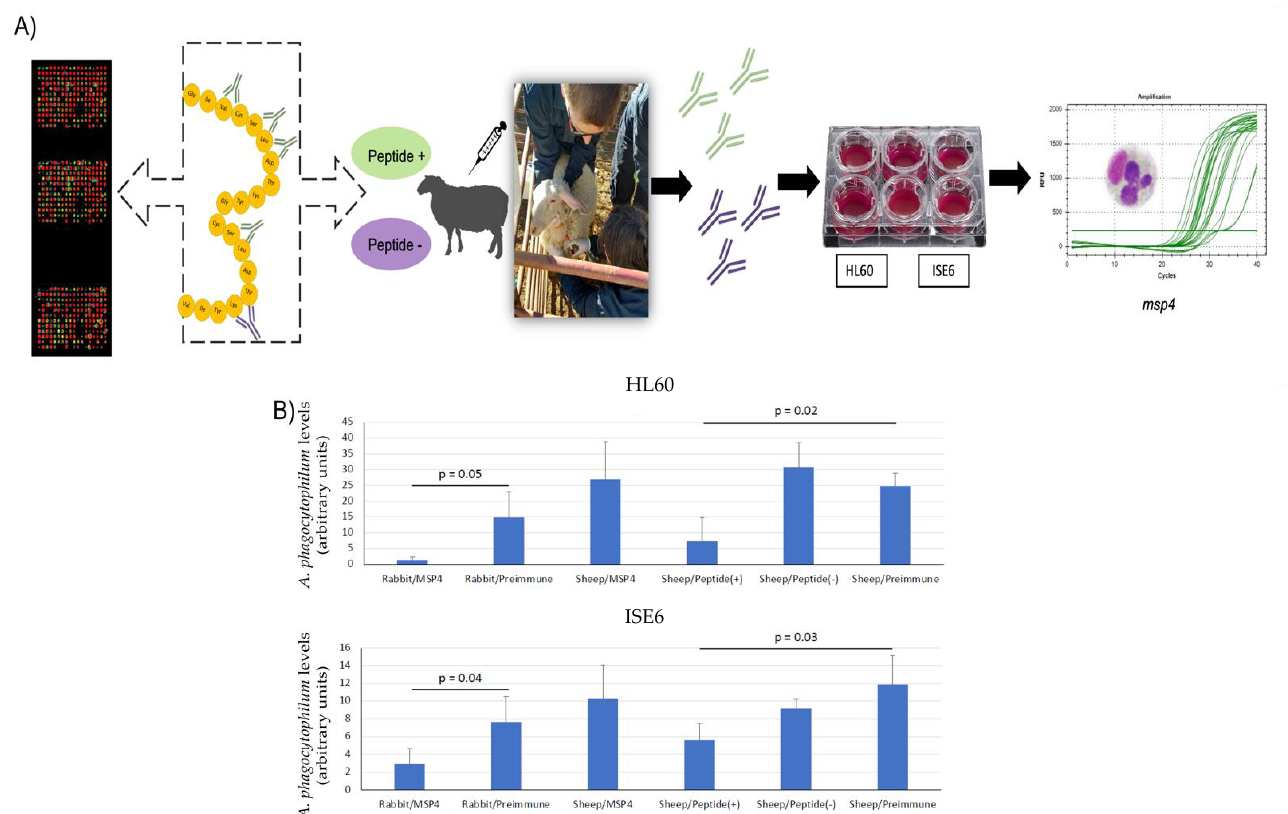
Figure 4. Experimental design in sheep. ( A ) mapping of protective epitopes with IgG from rabbits and lambs immunized with MSP4 [16]. Chimeric-antigens were designed based on protective epitopes identified by rabbit (Peptide+) and sheep (Peptide − ) IgGs and produced for sheep immunization. The IgGs from the sera of immunized sheep were used to assess the efficacy of the protective response to A. phagocytophilum by inhibition assay in tick ISE6 and human HL60 cells; ( B ) normalized msp4 levels in treated HL60 and ISE6 cells in the antibody inhibition assay; role of antibodies against chimeric recombinant proteins from immunized sheep in the inhibition of A. phagocytophilum human NY18 infection of HL60 and ISE6 cells. Purified IgGs antibodies against A. phagocytophilum MSP4 from immunized rabbits and sheep were used to characterize the inhibition of pathogen infection of HL60 and ISE6 cells in comparison with the protective capacity of IgG from sheep immunized with the new MSP4 chimeric antigens (peptide+/peptide − ) obtained from the MSP4 microarray analysis. Infection levels were determined by msp4 real-time PCR normalizing against human β -actin for HL60 cells and against tick rpS4 for ISE6 cells. Results were compared between groups treated with pre-immune/control and recombinant chimeric antigens antibodies by the Student’s t -test with unequal variance ( p < 0.05; n = 3 replicates per treatment). Relative infection levels were expressed in arbitrary